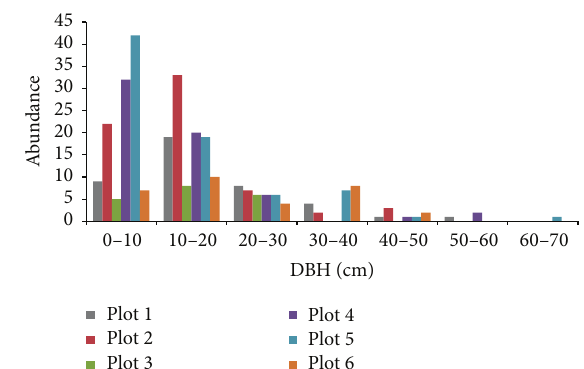
Figure 3: Size class distributions of trees in different DBH (cm) classes in six plots in the Tutong White Sands. Trees with DBH less than10cmwereclassifiedasjuveniles,whiletreesgreaterthan50 cm were classified as large